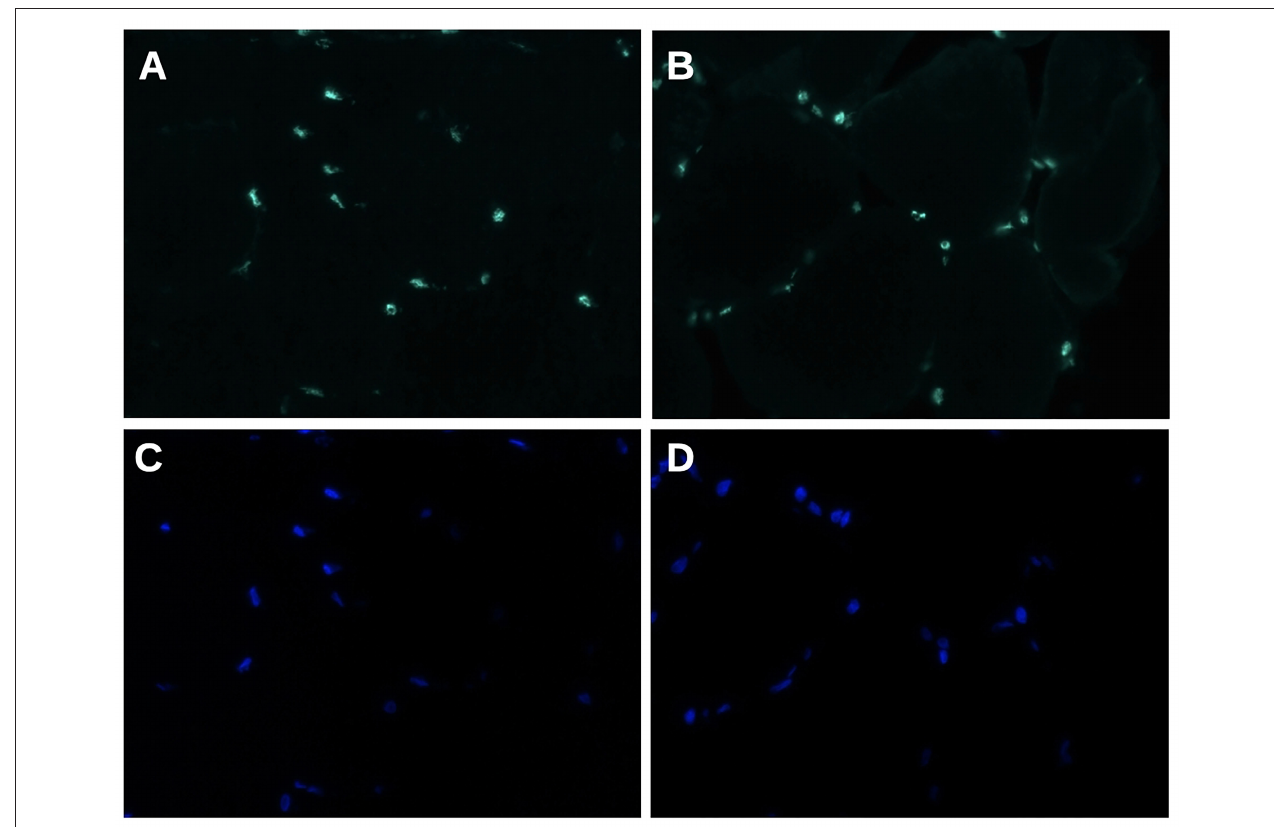
FIGURE 3 | Matrin 3 immunofluorescence staining (A,B) shows a uniform nuclear reactivity both in normal control (A) and in propositus muscle (B) . (C,D) Nuclei stained with DAPI. Original magnification 400 ×